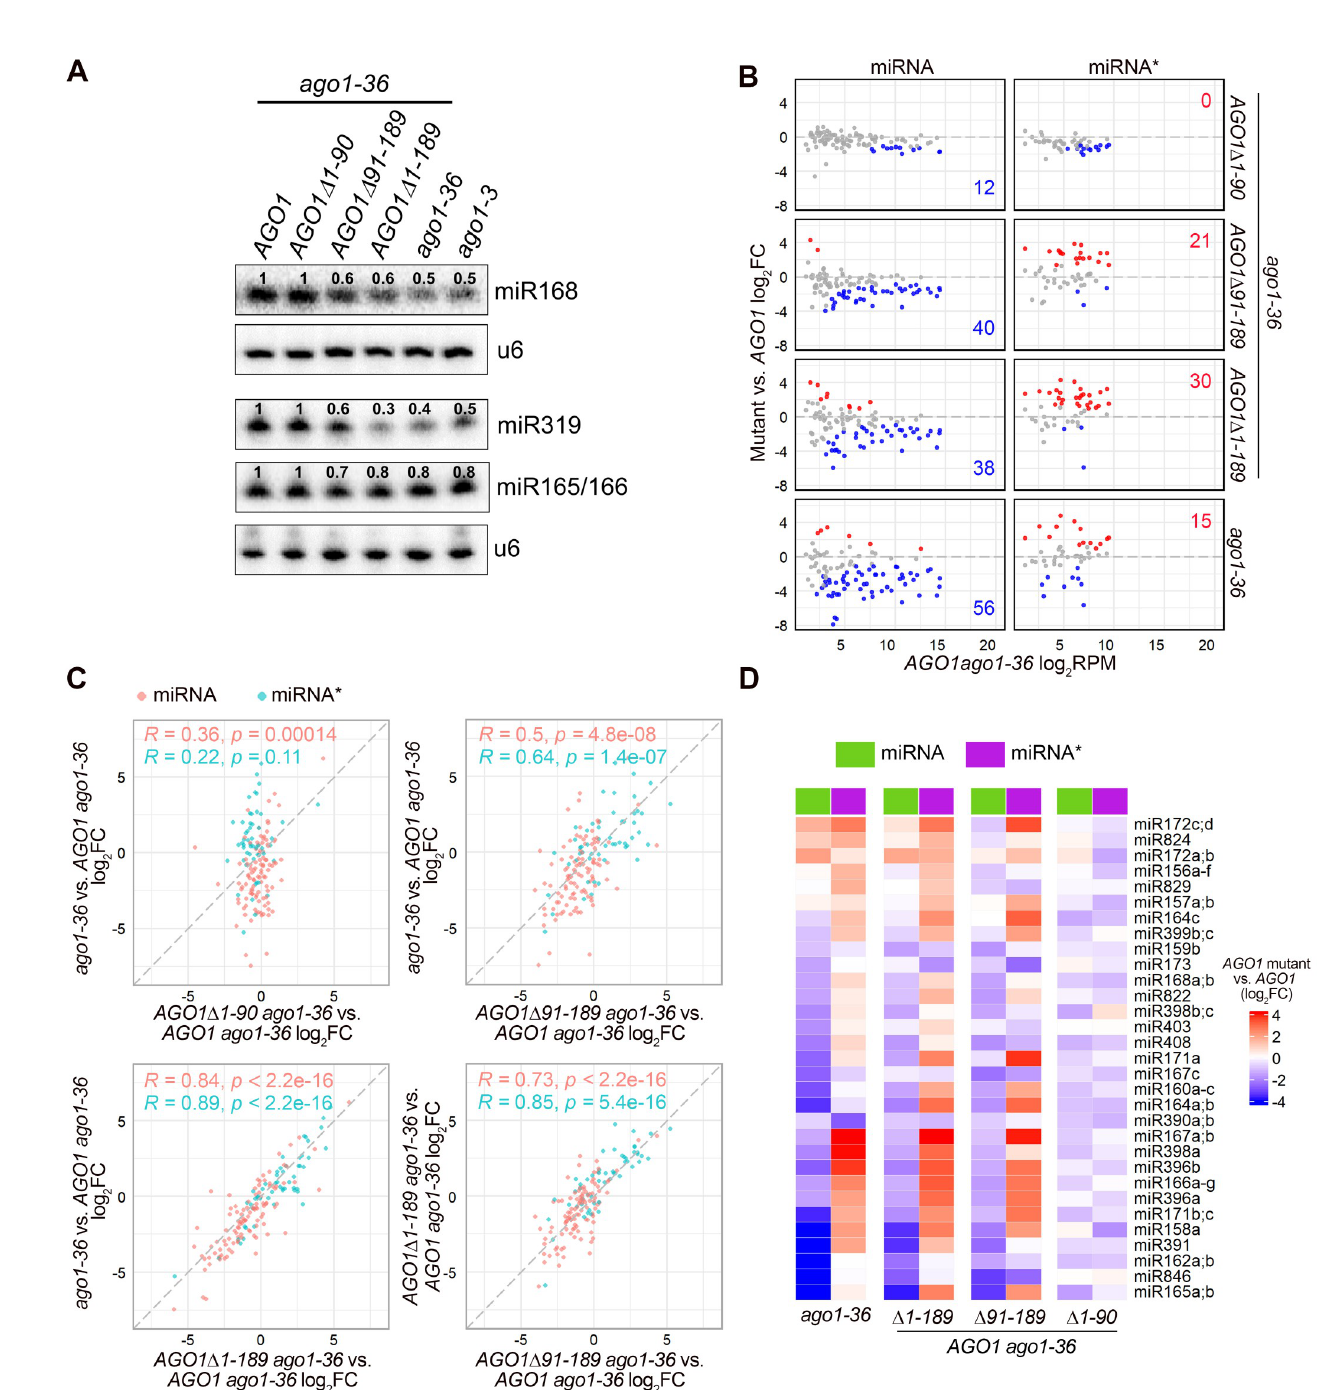
Fig 2. The AGO1 N-terminal extension is required for miRNA accumulation. (A) RNA gel blot analysis of miRNA abundance in 12-day-old seedlings of ago1-3 , ago1-36 , and ago1-36 expressing AGO1 full-length or various NTE-truncated forms. The numbers represent miRNA abundance in different genotypes relative to AGO1 ago1-36 . The U6 blots serve as a loading control for the miRNA blots above. (B to D) Small RNA-seq analysis of 12-day-old seedlings. Except for ago1-36 , all lines contain pAGO1 : 3XHA-AGO1 or pAGO1 : 3XHA-AGO1 NTE-truncated forms in the ago1-36 background. Three biological replicates of each genotype were included in the analysis. (B) Scatter plots showing the abundance of miRNAs and miRNA � s in AGO1 ago1-36 (X axis) and fold change between AGO1 mutants and AGO1 (Y axis). Red and blue dots denote miRNAs or miRNA � s with significantly increased and decreased abundance (average RPM > 2, fold change > 1.5 and adjust P value < 0.01), respectively. (C) Scatter plots comparing the log 2 (fold change) of miRNAs and miRNA � s between pairs of genotypes. Pearson’s correlation